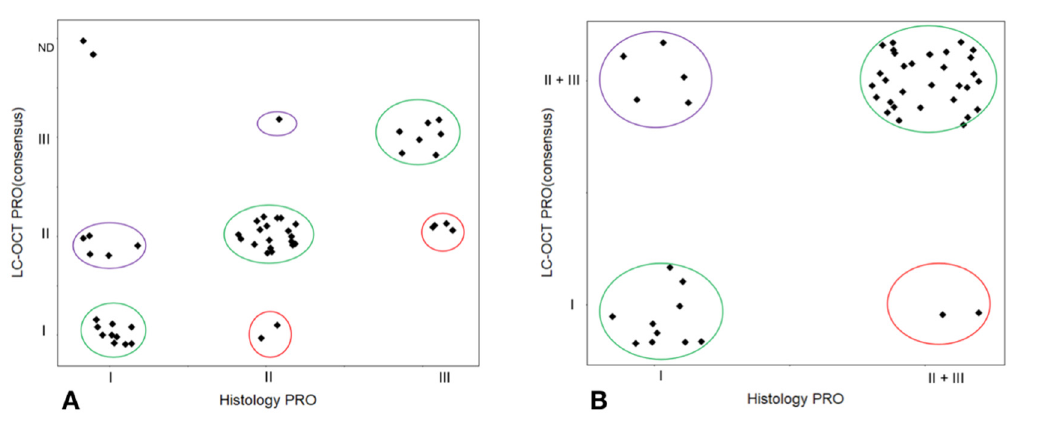
Figure 3. Overall ( A ) and subgroup ( B ) correlation between LC-OCT and histopathological PRO grading of AKs. ND: not definable.